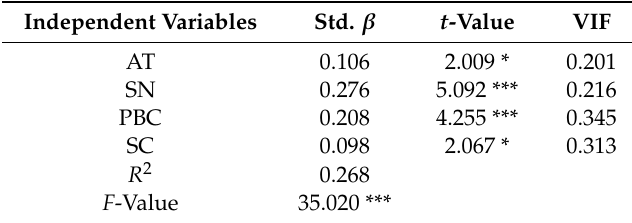
Table 4. Regression analysis result on continuance intention.